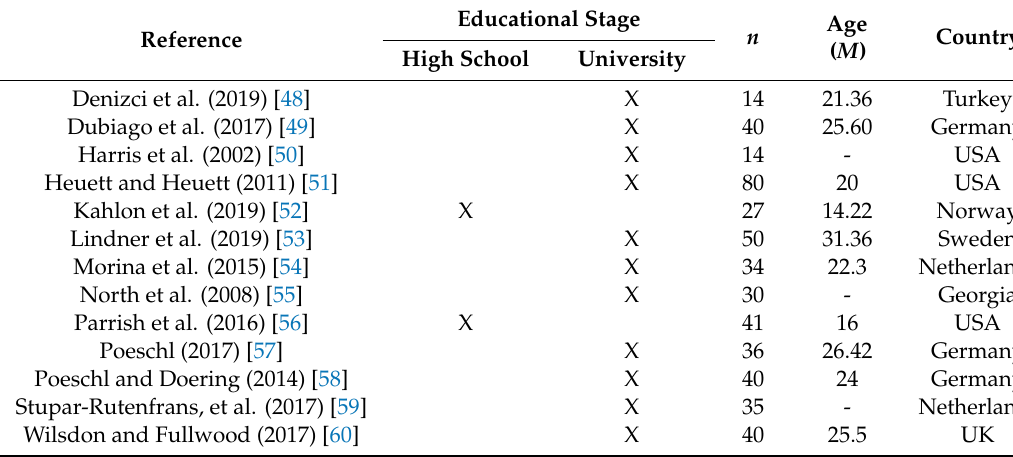
Table 5. Characteristics of the